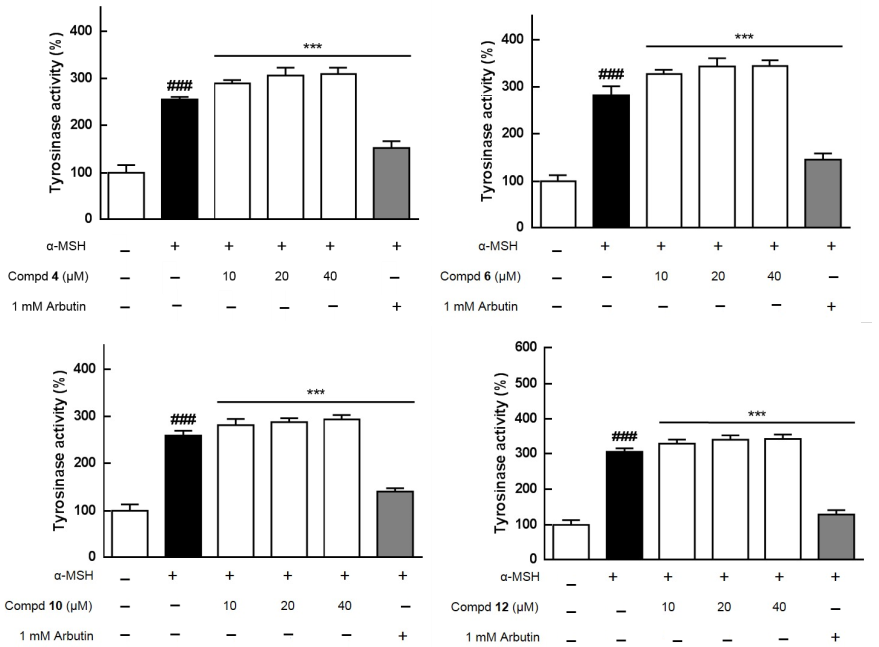
Figure 5. Tyrosinase activity effects of compounds 4 -, 6 -, 10 -, and 12 -treated B16 melanoma cells. ###, p < 0.05 compared with the control group; ***, p < 0.001 compared with the α -MSH-treated group.